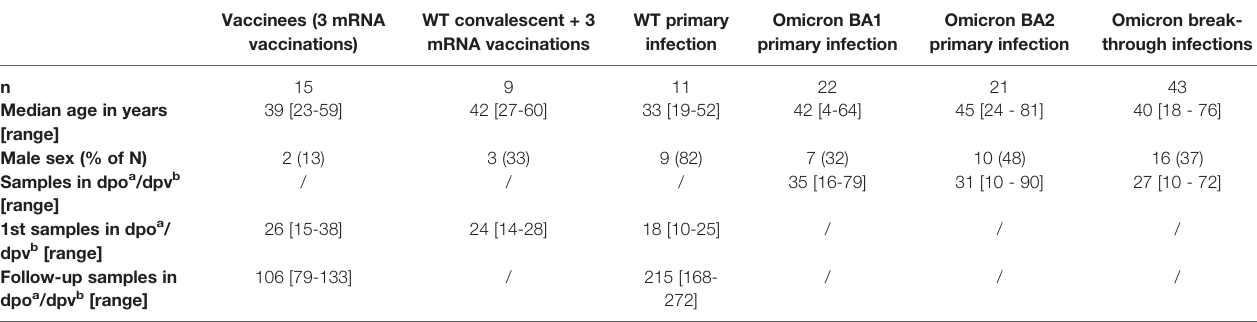
TABLE 1 | Demographics of study cohorts and sampling time